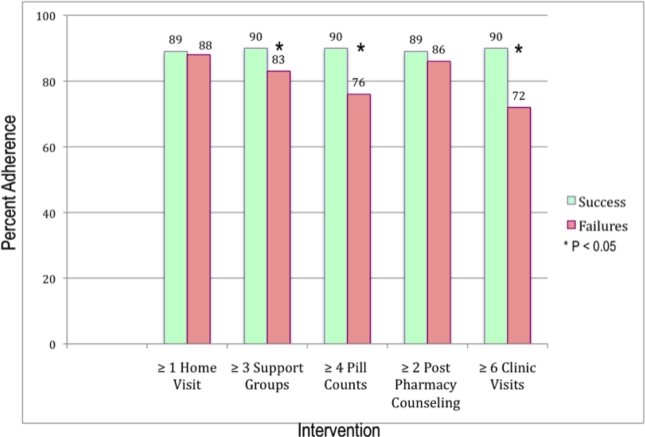
Rates of Adherence Categorized by Interventions.Rates of adherence in treatment successes and failures is shown by each intervention: 1) greater than one home visit; 2) participation in two or more support groups; 3) having four or more unannounced pill counts by primary care provider; 4) having two or more counseling sessions by a pharmacist; 5) completing six or more clinic visits.